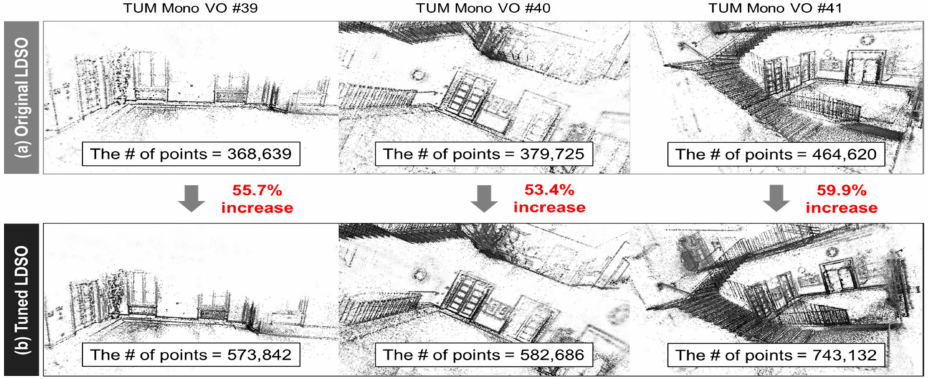
Figure 3. Examples of reconstructed 3D point clouds on TUM Mono VO dataset: original vs. tuned LDSO.